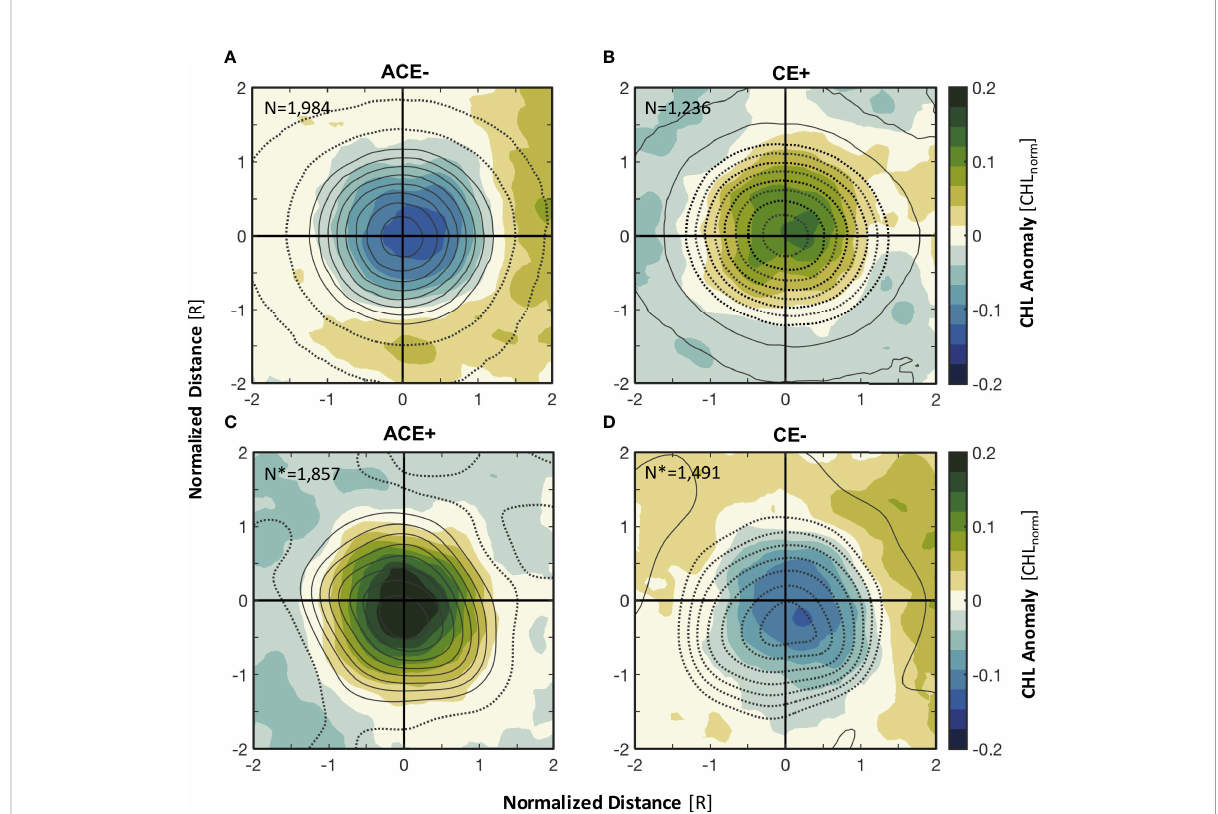
FIGURE 5 Total composite averages of CHL anomalies for (A) ACE-, (B) CE+, (C) ACE+, and (D) CE- in the northern Norwegian Sea for April to September. The contours in (A, B) represent the composite averages of SLA (contour interval 1 cm), and those in (C, D) represent eddy-induced Ekman pumping (contour interval 1 cm d -1 ). Positive SLA and Ekman pumping are represented as solid curves; negative SLA and Ekman pumping are represented as dashed curves. The x and y coordinates of the composite averages are normalized by the eddy radius (R). N and N* represent the number of eddy realizations for construction of the